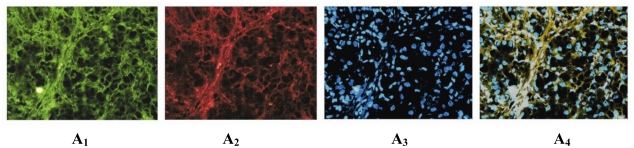
Integrin αv, β3 and Lewis y colocalize in ovarian malignant tumor. Using an immunofluorescent double-labeling method. Integrin αv and β3 (A1 and B1); Lewis y (A2 and B2); nucleus (A3 and B3); Merged image (A4 and B4). (Original magnification ×400).